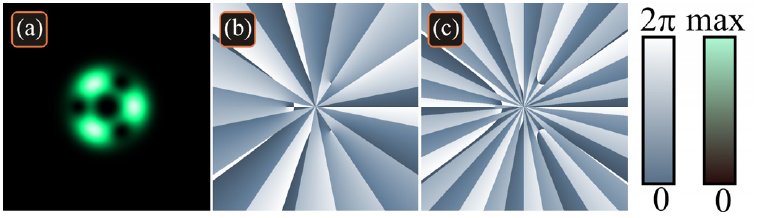
Figure 8. Intensity ( a ) and phase ( b , c ) distributions of a superposition of two single-ringed LG beams